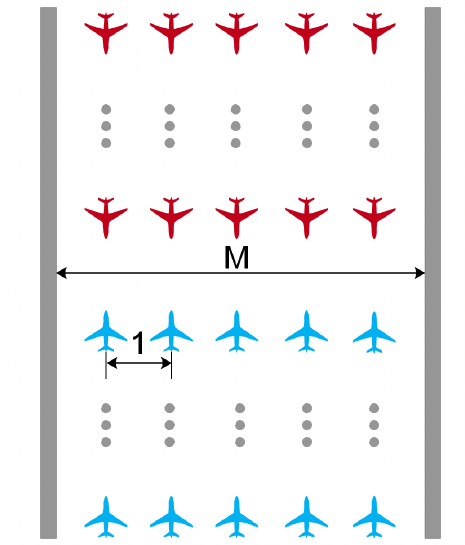
Figure 3. Two swarms fight head-on over a narrow